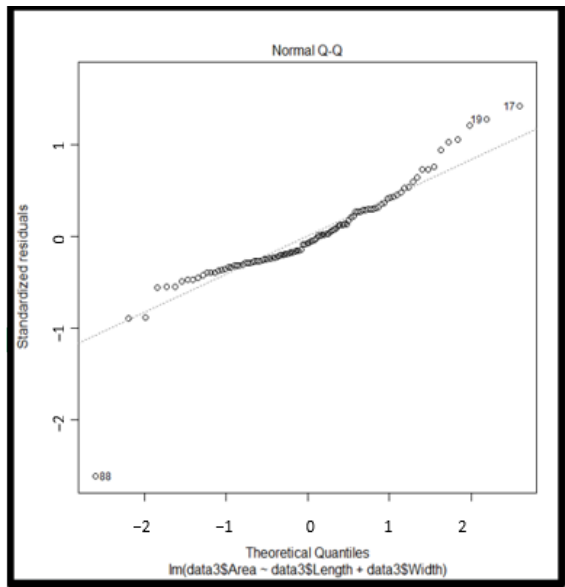
Figure 1. Fitted line graph of the leaf area of quina. Table 3. Results obtained from the linear model implemented in R.